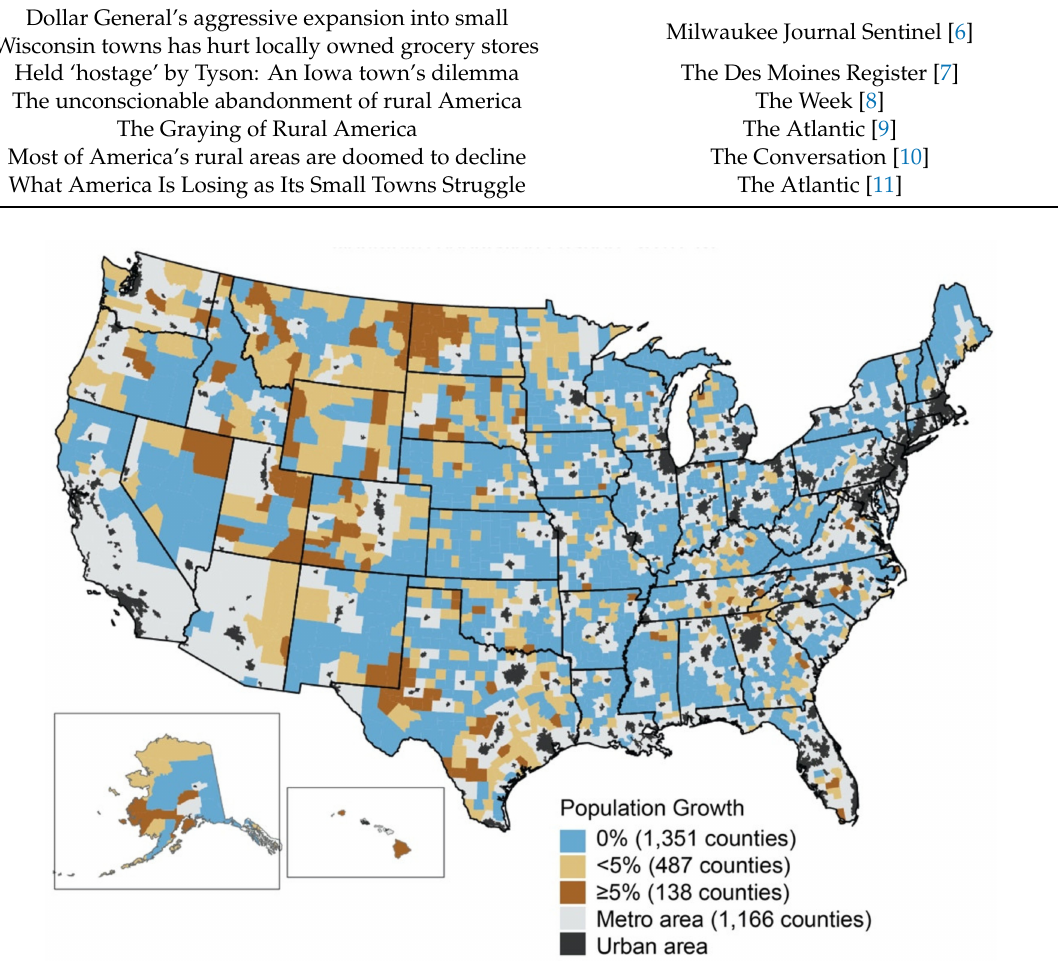
Figure 1. Nonmetropolitan population change, 2010–2016. (Adapted from